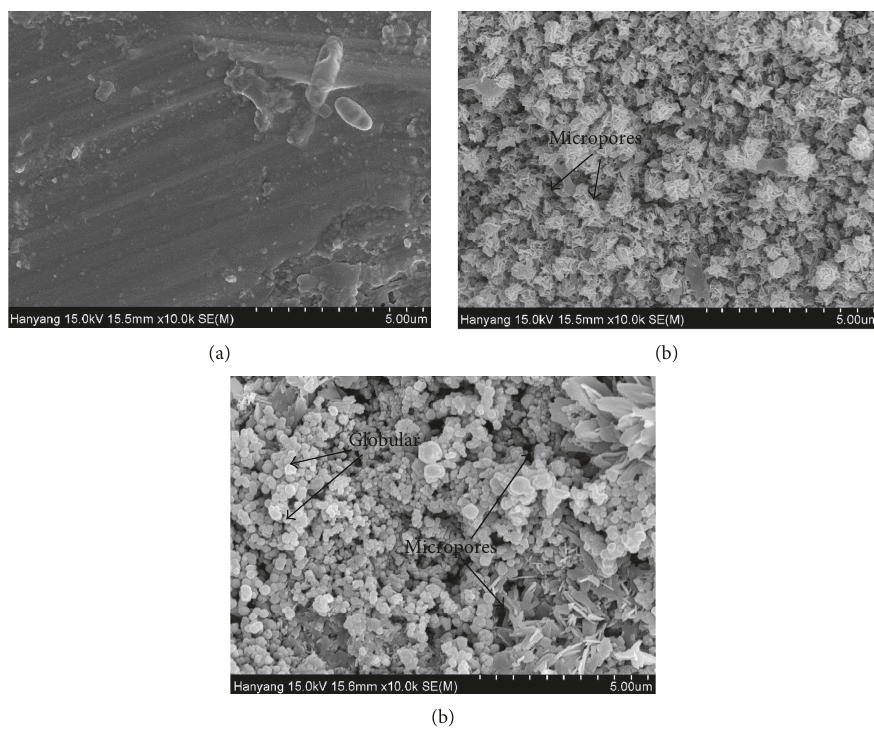
Figure 7: SEM images of corrosion products formed on the (a) SS plate, (b) SS-sprayed coating, and (c) Ti-sprayed coating after potentiodynamic studies in pH 4